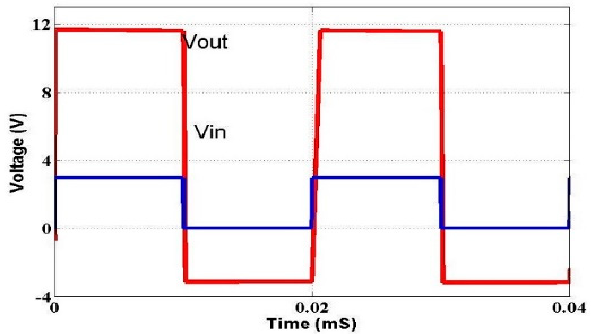
Figure 6. Input and output signal waveform of MOSFET driver circuit.